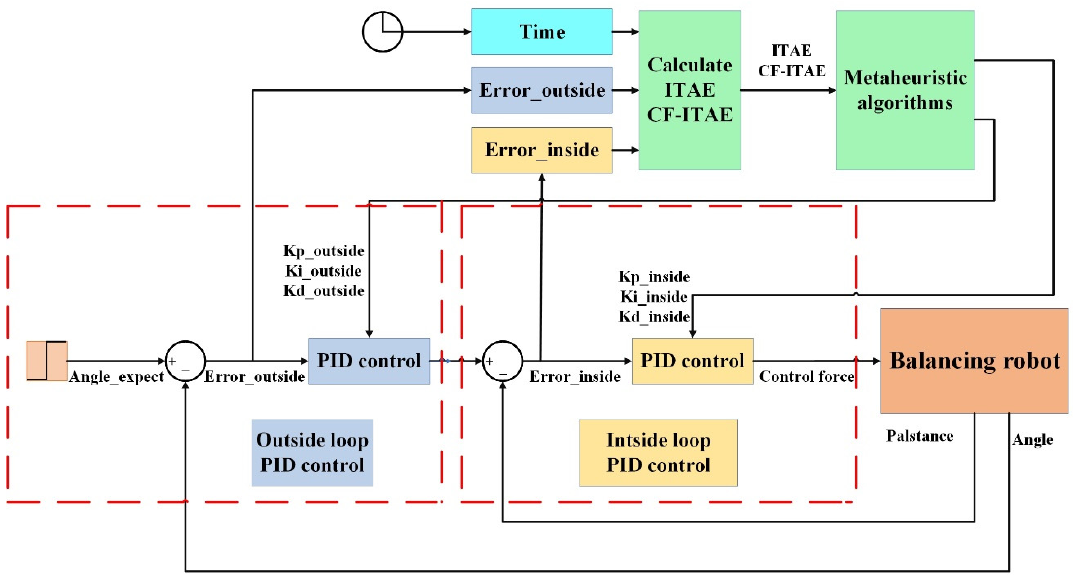
Figure 7. The Simulink model of Dual-loop PID attitude control of the balancing robot. Table 1. Parameters related to balancing robot attitude control.